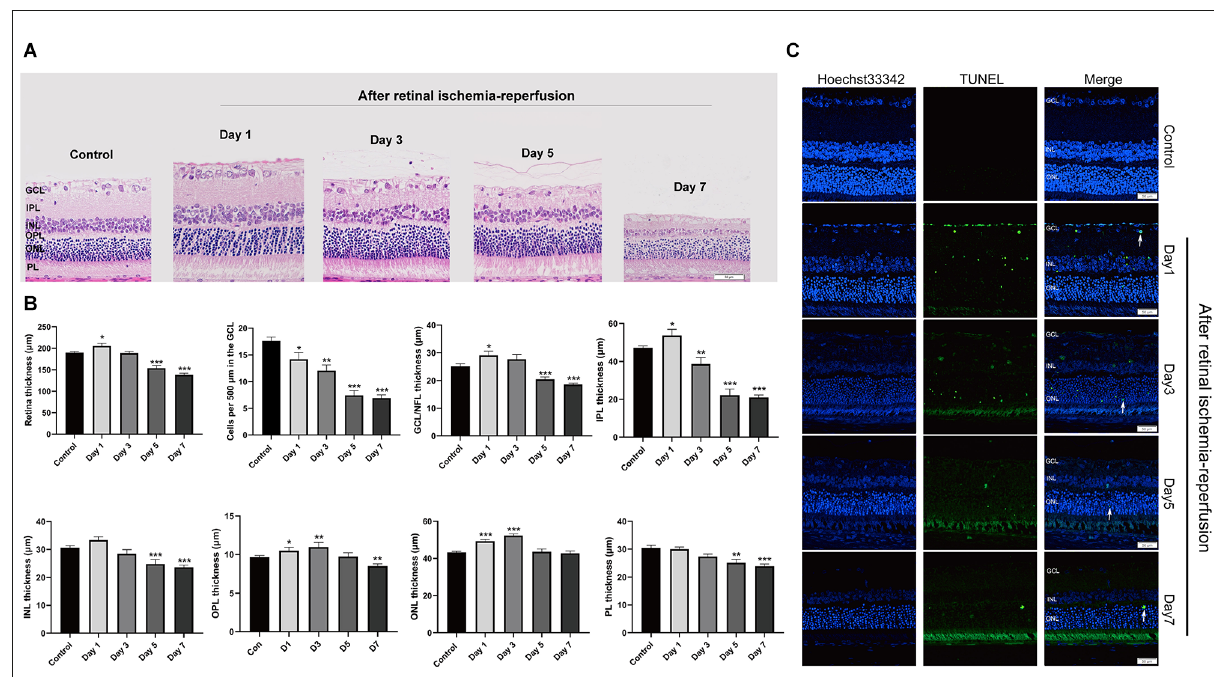
FIGURE2 HIOP was used to cause RIRI in rats. (A) After retinal ischemia-reperfusion for 1, 3, 5, and 7 days, H&E staining of retinal cross-sections showed degeneration of RGCs and a decrease in the thickness of retinal tissue. GCL, ganglion cell layer; INL, inner nuclear layer; IPL, inner plexiform layer; ONL, outer nuclear layer; OPL, outer plexiform layer; PL, photoreceptor layer ( n = 5). Scale bar: 50 µ m. (B) Measurement of retinal thickness from the ganglion cell layer (GCL) to the photoreceptor layer (PL); the number of cells per 500 µ m in the GCL and the mean thicknesses of different retinal layers in retinal ischemia-reperfusion rats at 1, 3, 5, and 7 days are shown. (C) Apoptotic cells were detected by TUNEL assay in retinal sections 1, 3, 5, and 7 days after ischemia-reperfusion injury in rats. Representative images of TUNEL-positive cells (green) are shown. The nuclei were counterstained with Hoechst 33342 (blue). Scale bar: 50 µ m. The data are presented as the mean ± SEM (* P < 0.05, ** P < 0.01, *** P < 0.001. n = 5 for each group). HIOP, high-intraocular pressure; RIRI, retinal ischemia-reperfusion injury; TUNEL, terminal deoxynucleotidyl transferase dUTP nick end